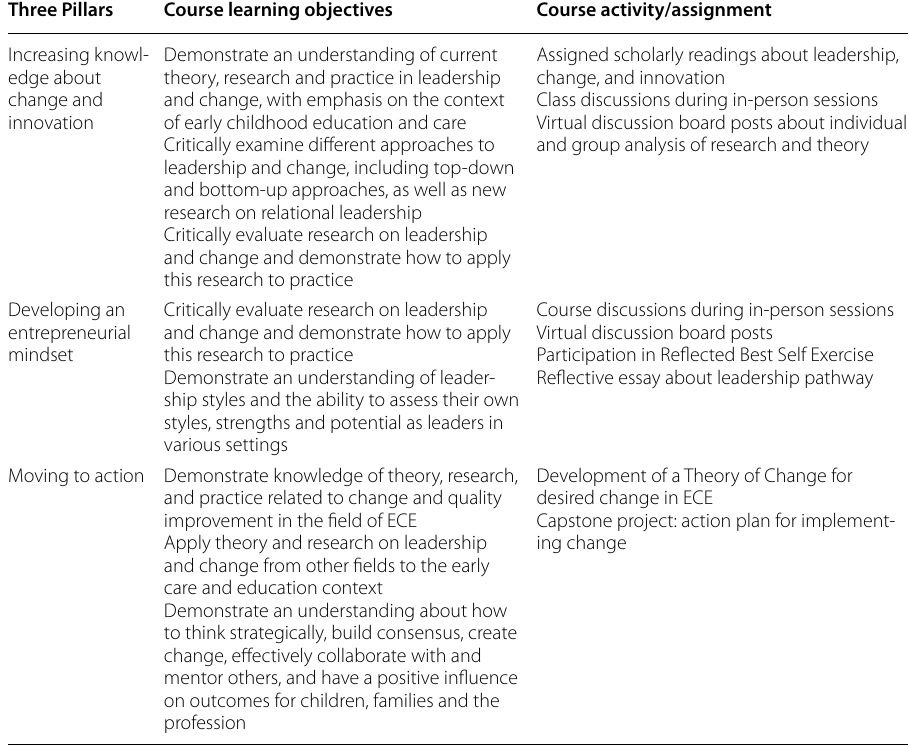
Table 2 Key learning activities of the LfC program Three